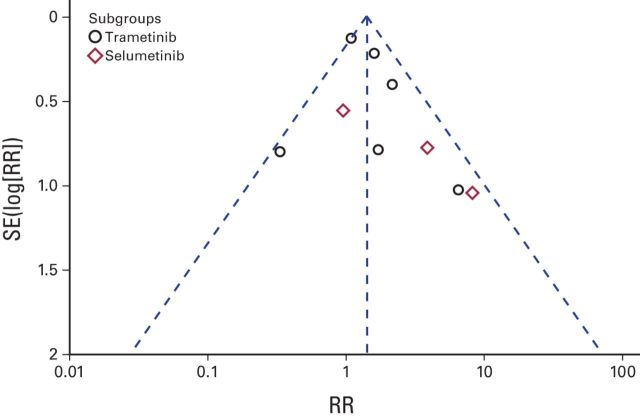
Funnel plot for publication bias for all-grade hypertension. RR, risk ratio.